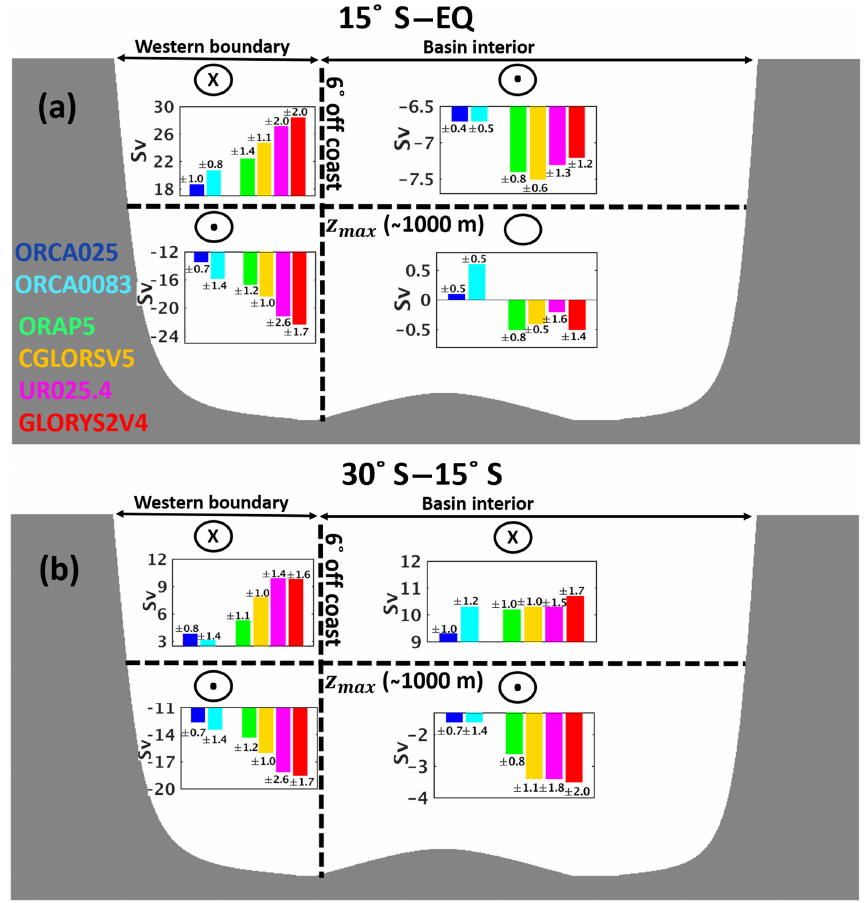
Figure 11. Four-box model of the averaged transports (1997–2010, in Sv) from (a) 15 ◦ S to the Equator and from (b) 30 to 15 ◦ S; 6 ◦ off the coast is chosen to separate the western boundary from the basin interior. The depth of maximum SAMOC z max for each product is used to separate the upper and deep circulations. The circles with “x” and dots represent flow going into and out of the page, respectively. The empty circle means that there is no agreement about the direction of the flow; ± corresponds to the inter-annual variability of each